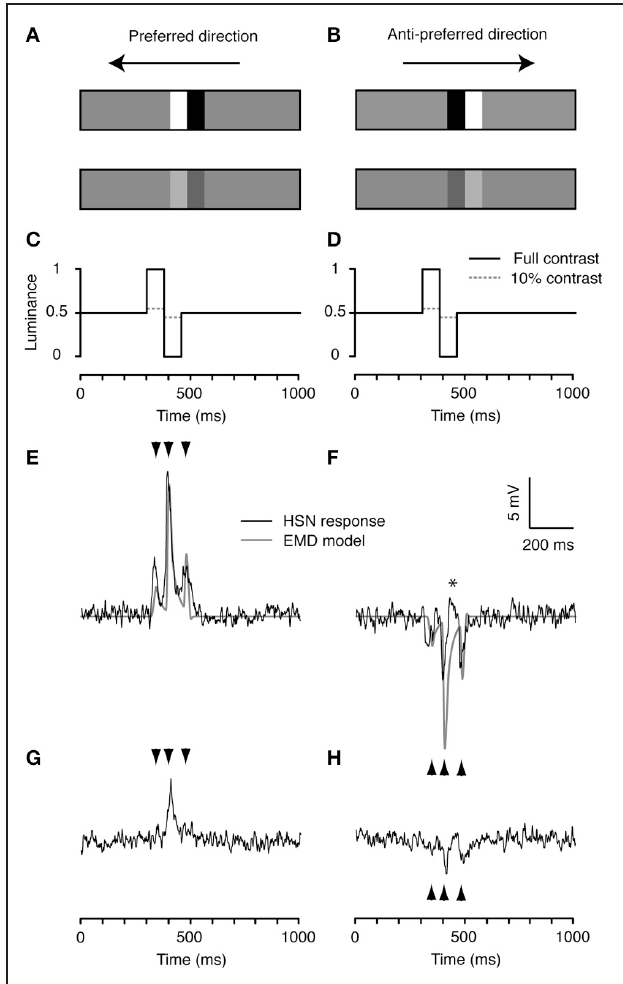
FIGURE 2 | Doublet stimuli. (A,B) A combination of two square-wave, white-black luminance steps on mean luminance (gray) background, referred to as a doublet. The doublet is 14 ◦ wide and 75 ◦ high and has a fundamental row frequency of 0.053 cycles/ ◦ , near optimal for hoverfly HS neurons (Straw et al., 2006). We simulated doublet motion at 90 ◦ /s with the doublet at either full or 10% contrast in both the preferred (A) and anti-preferred direction (B) . For display purposes the doublets are not shown at their true contrasts or size. (C,D) . Normalized time-luminance graphs as seen at the first edge of the slit-window, i.e., the right hand edge for preferred, right-to-left motion, and the left hand edge for anti-preferred left-to-right motion. Solid black lines represent the full contrast condition, dashed gray lines show the 10% original contrast condition. (E) The doublet stimulus produces a characteristic triphasic response from the EMD model in the preferred direction (gray). The neuron’s response (black) is also characterized by a triphasic response profile that closely resembles the model output. (F) The EMD output (gray) is similar, but inverted, in the anti-preferred direction. The neuron’s response is shown in black. The star ( ∗ ) indicates a brief depolarization of the membrane potential. (G,H) The neural responses to the low contrast doublet. Arrowheads indicate the timing of the output peaks produced by the model in panels (E,F) . Although responses are qualitatively indistinguishable from one recording to the next, absolute response magnitude can vary. To enable accurate comparison of the responses across the six stimulus conditions in Figures 2 – 4 , we show the response to one neuron in which all six conditions were performed, n = 20.